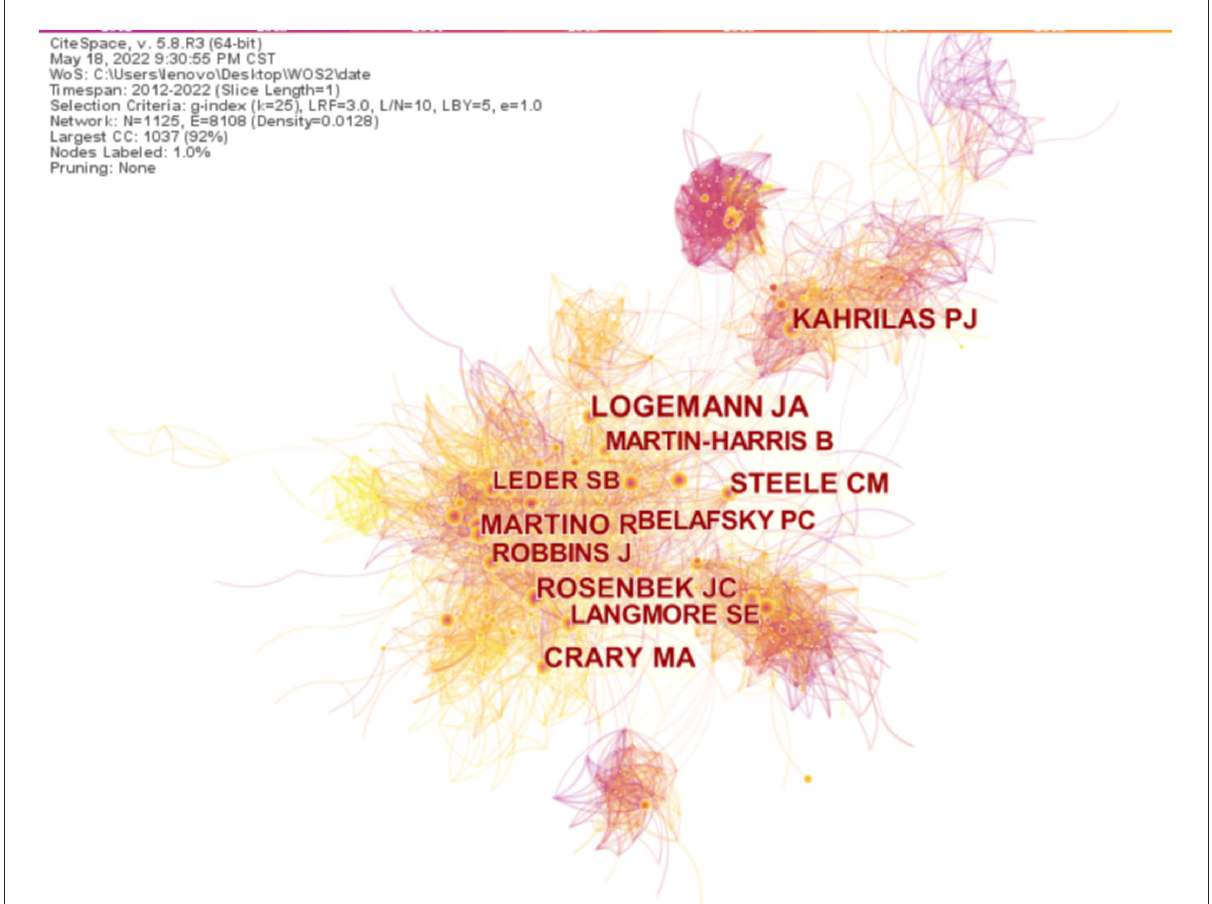
FIGURE7 Map of cited journals distribution and relations on dysphagia from 2012 to 2022. The shorter the distance between the two circles, the more the cooperation between the two cited authors.